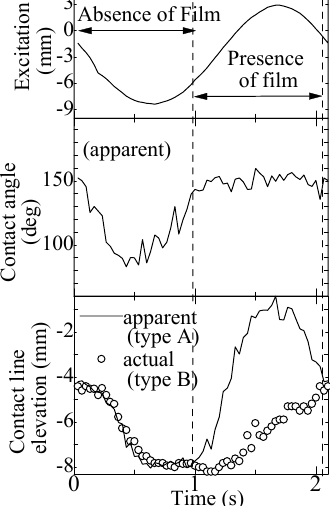
Fig. 4 Trends of measured variables.